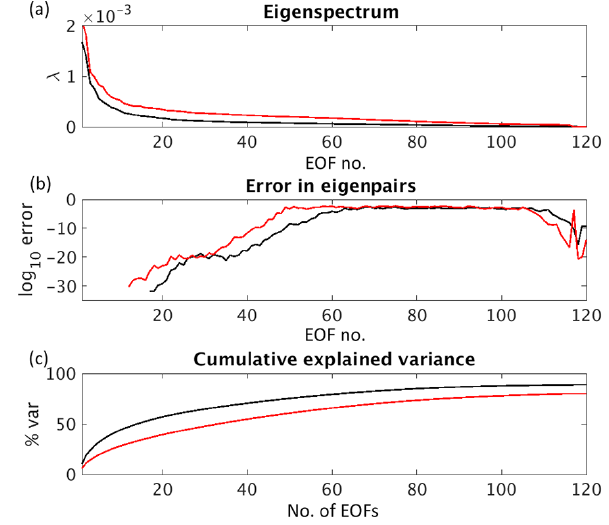
Figure 2. (a) An estimate of the leading 120 eigenvalues λ of e C 0 based on 120 iterations of the Lanczos algorithm using unsmoothed (red curve) and smoothed (black) δ x i . (b) Log 10 of formal error estimates of | e C 0 ψ j − λ ψ j | vs. EOF number j using unsmoothed (red curve) and smoothed (black) δ x i . (c) The cumulative percent variance explained vs. the number of EOFs using unsmoothed (red curve) and smoothed (black) δ x i .